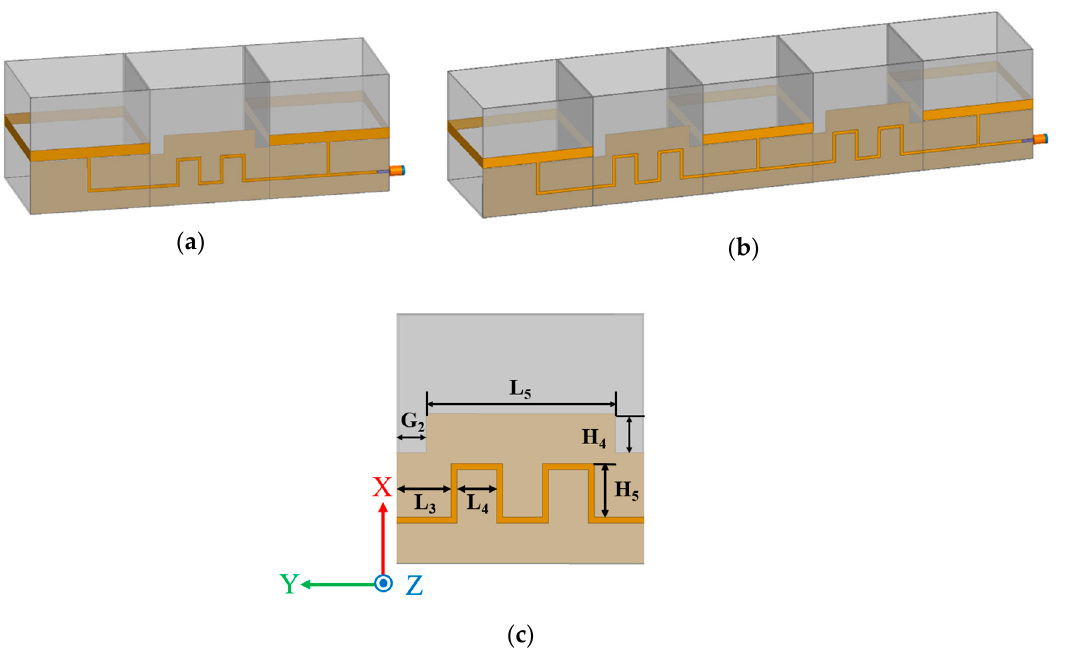
Figure 3. Illustration of the ( a ) two-element antenna array and ( b ) three-element antenna array. ( c ) Layout of the series feeding